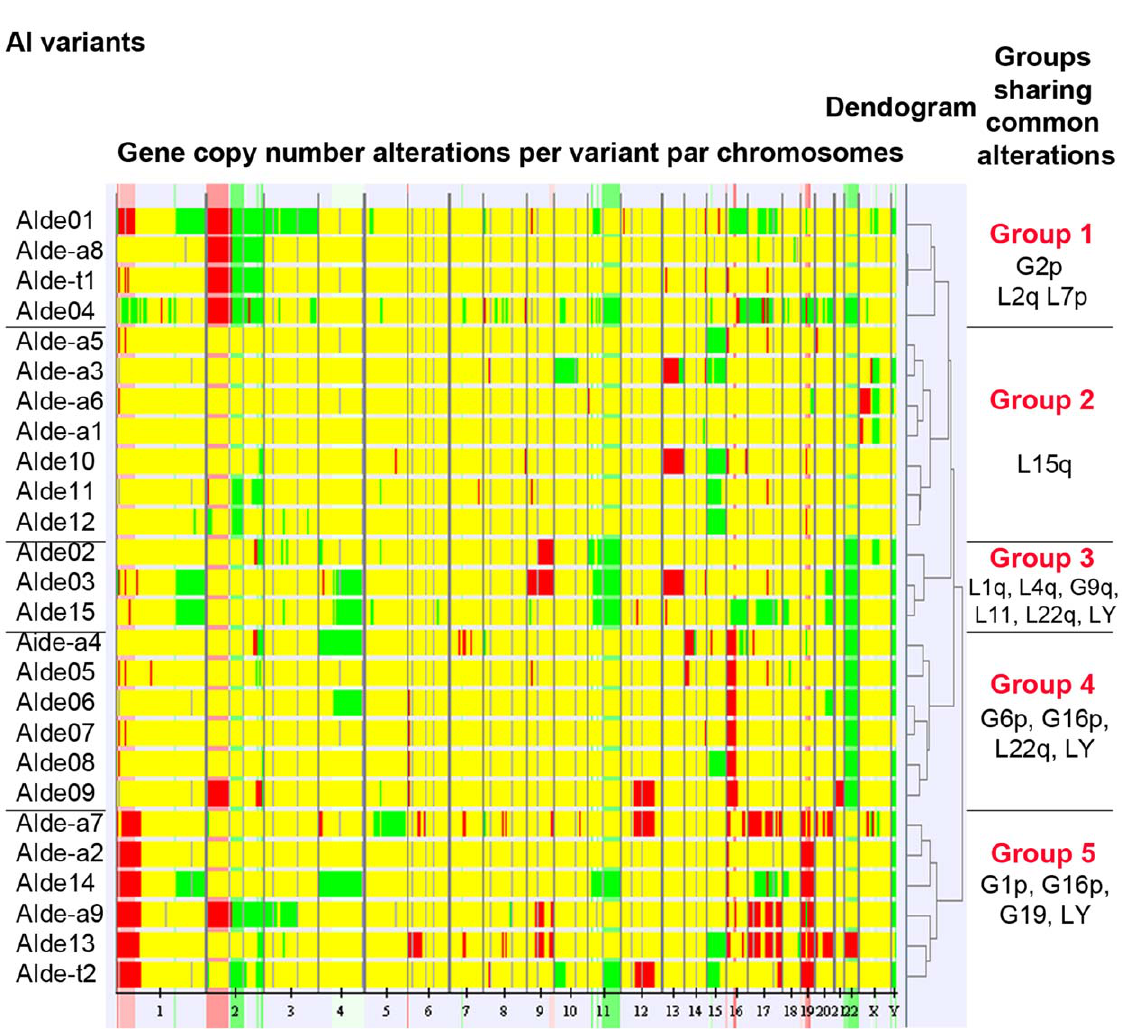
Figure 2. Unsupervised hierarchical clustering analysis on gene copy number alterations. There was no relationship between gene copy number alterations and the type of hormone treatment. The left hand column indicates numbered AI variants by treatment where de denotes degarelix, de-a degarelix plus antiandrogen (bicalutamide or flutamide), de-t degarelix plus trastuzumab. Green and red colors correspond to losses and gains of gene copy number, respectively. Yellow corresponds absence of difference in terms of gene copy number between AI variants and parental PAC120 DNA.